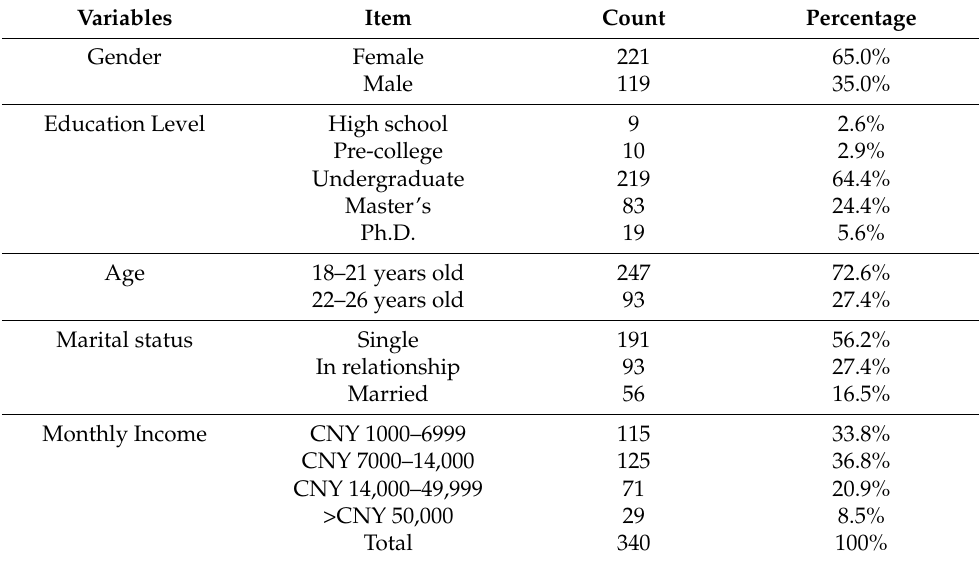
Table 2. Key demographic characteristics of the survey participants.